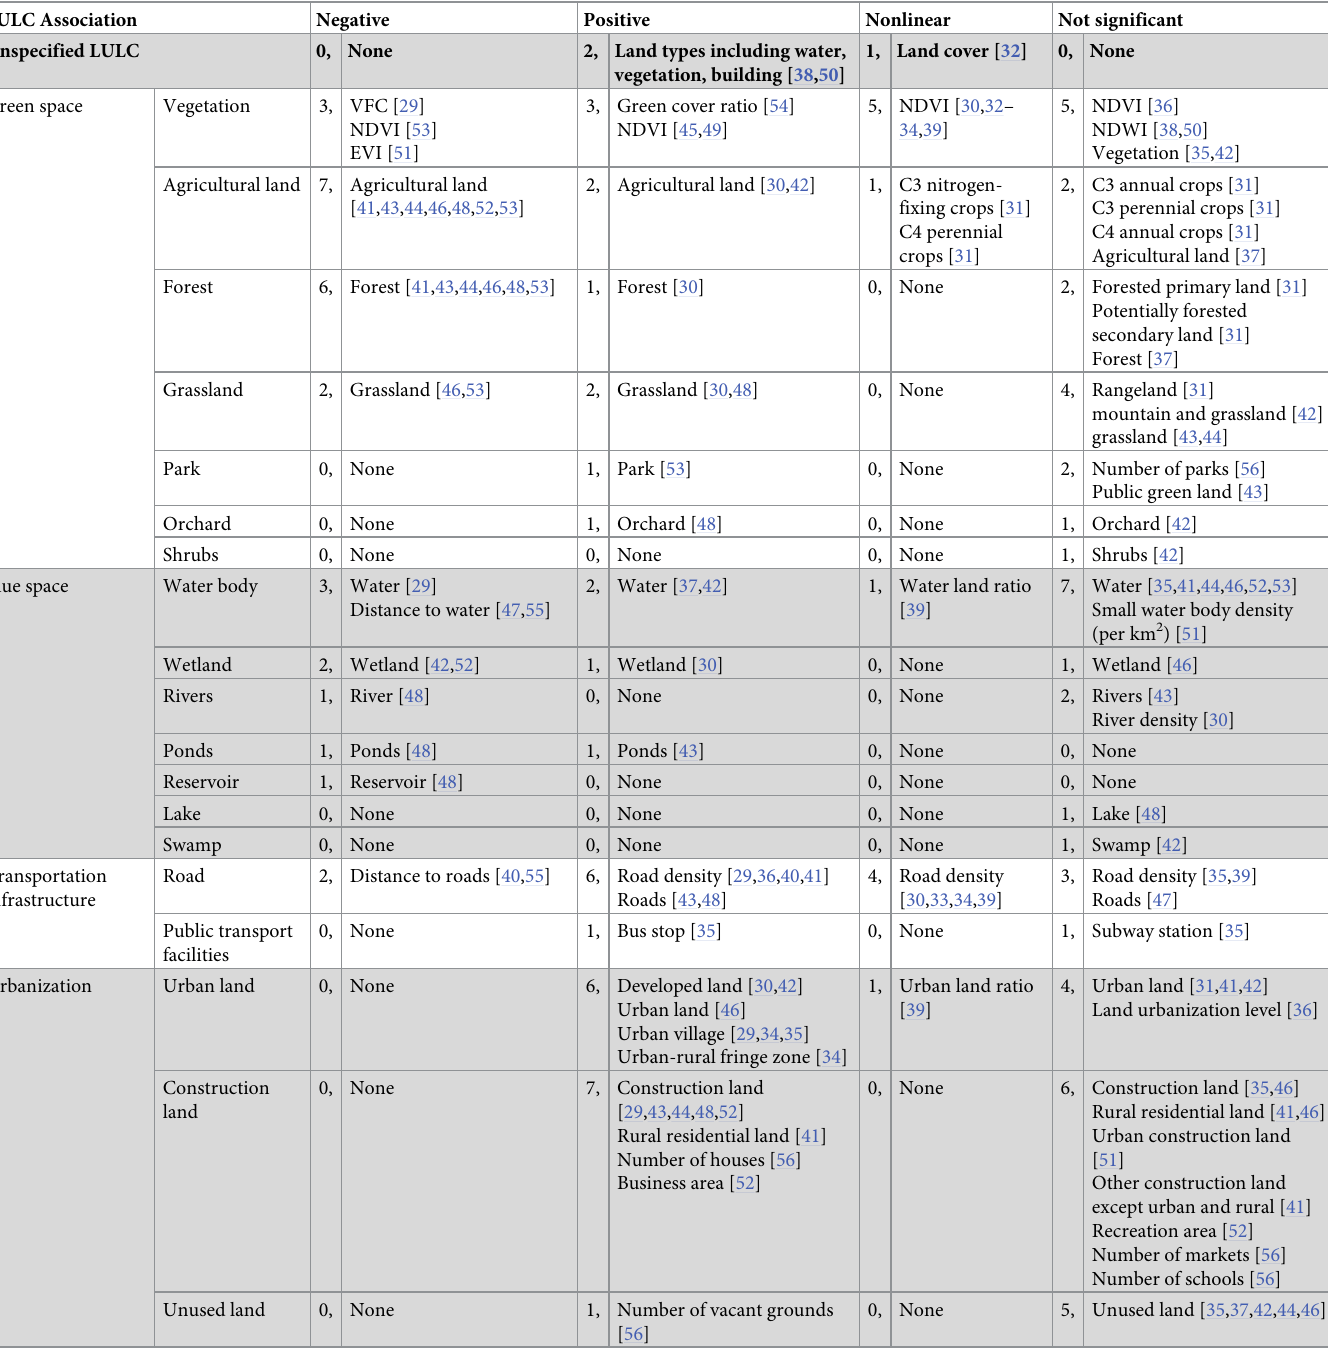
Table 2. The effects of LULC change factors on dengue dynamics in selected articles (number of related studies, indicator/land type). LULC